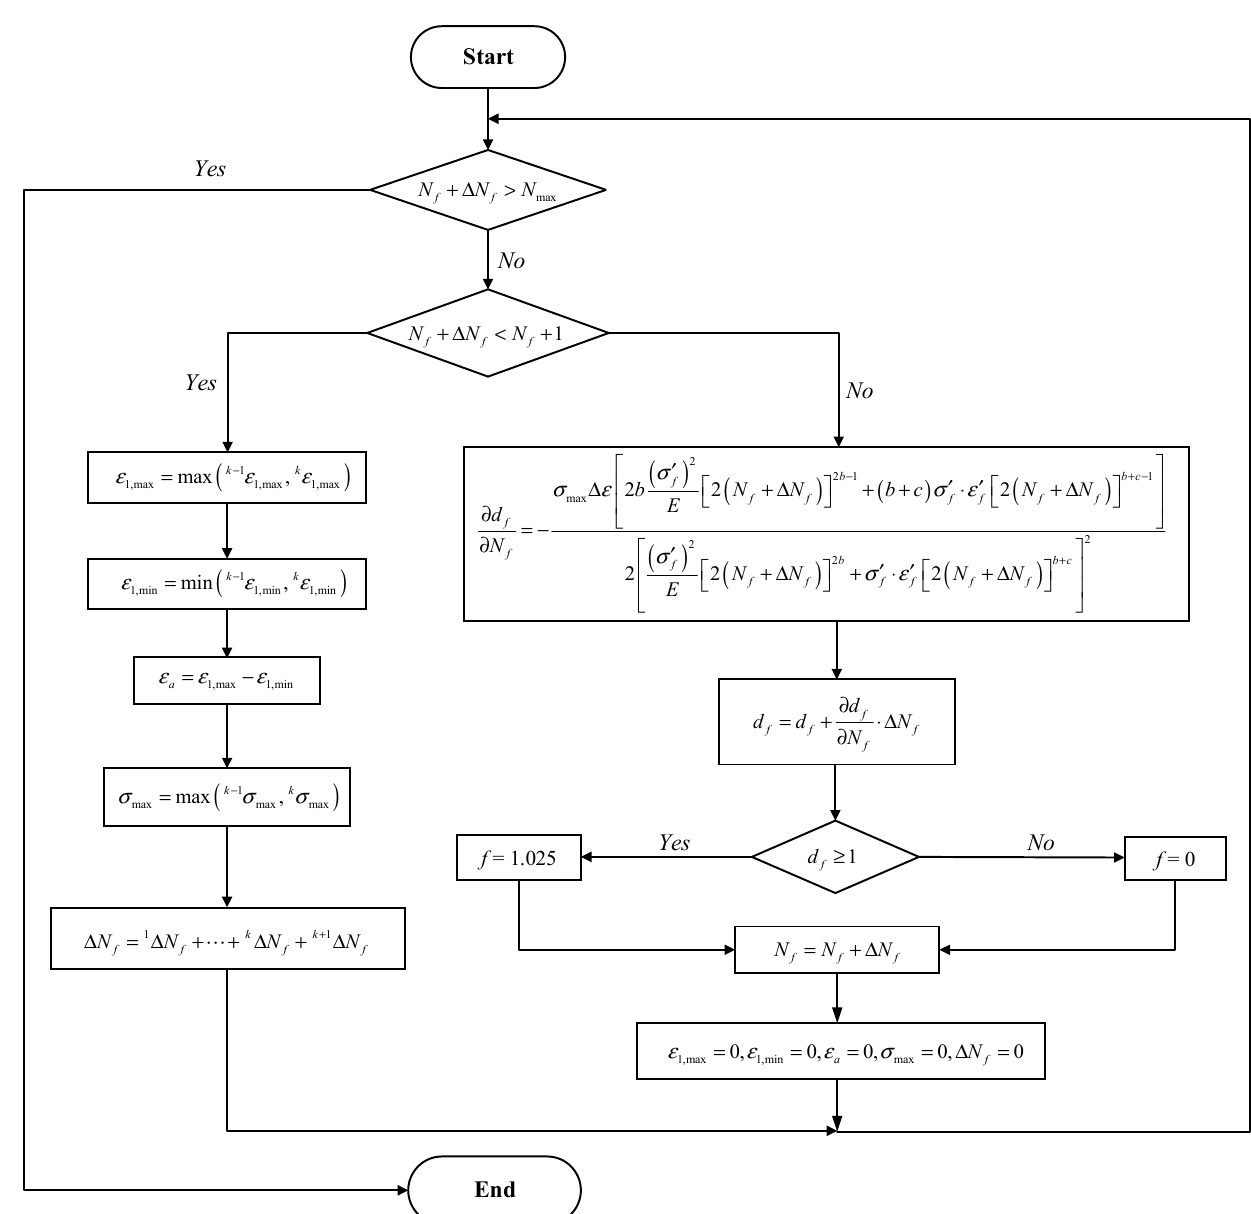
Figure 1. Flowchart of the fatigue damage initiation model.